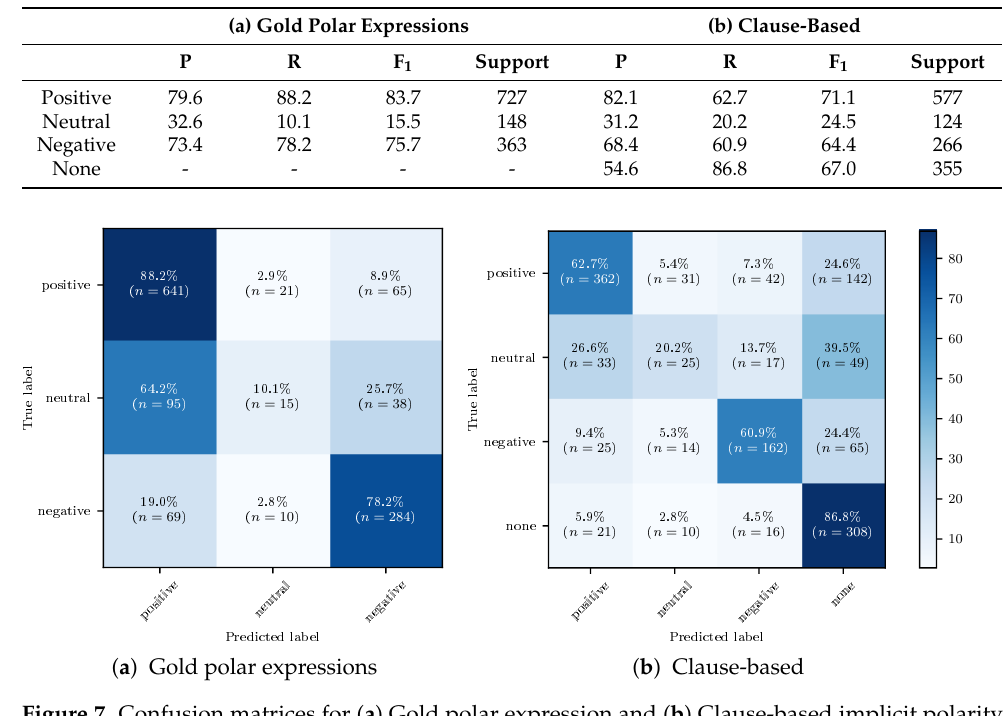
Figure 7. Confusion matrices for ( a ) Gold polar expression and ( b ) Clause-based implicit polarity